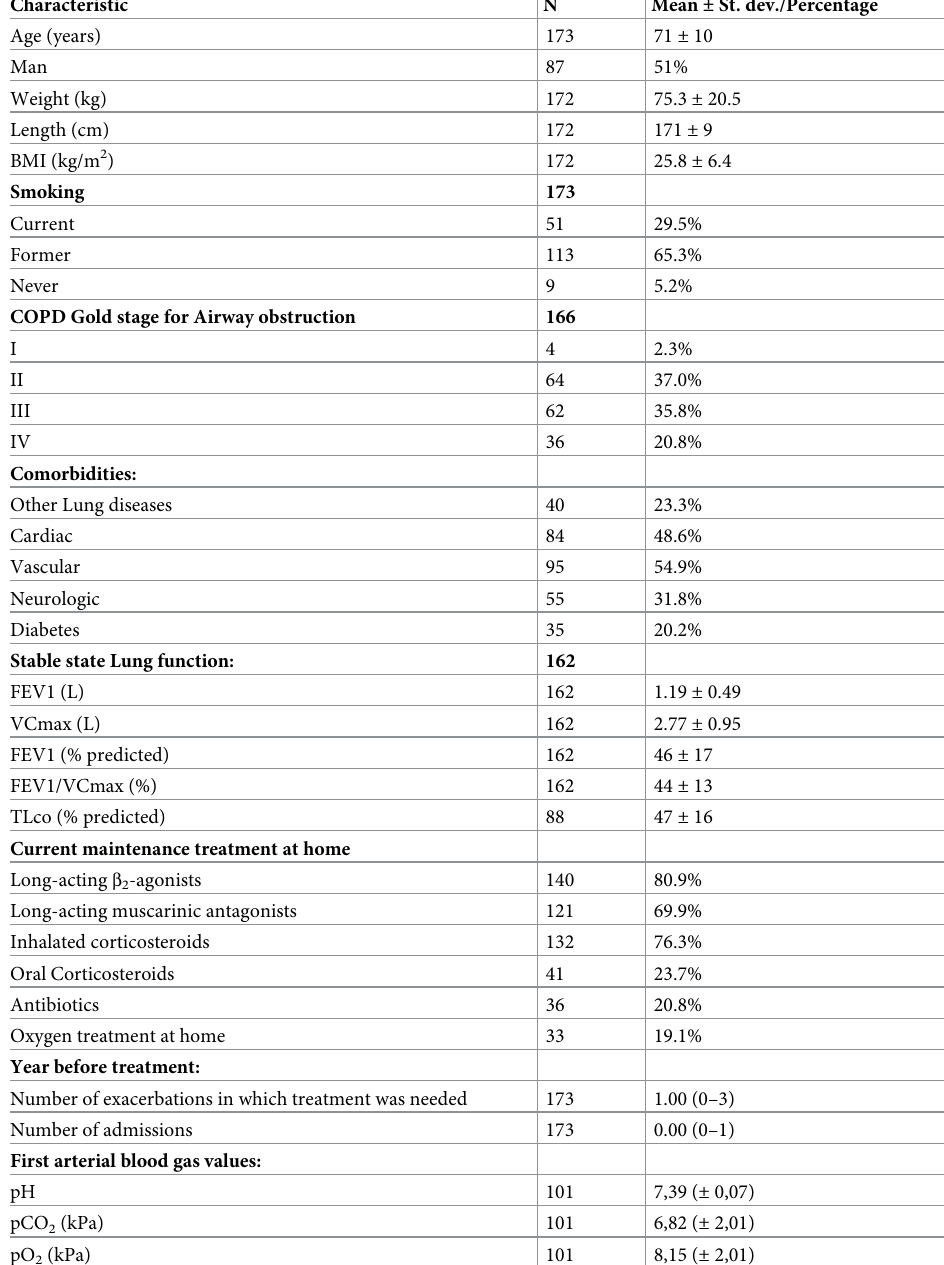
Table 1. Baseline characteristics of the included